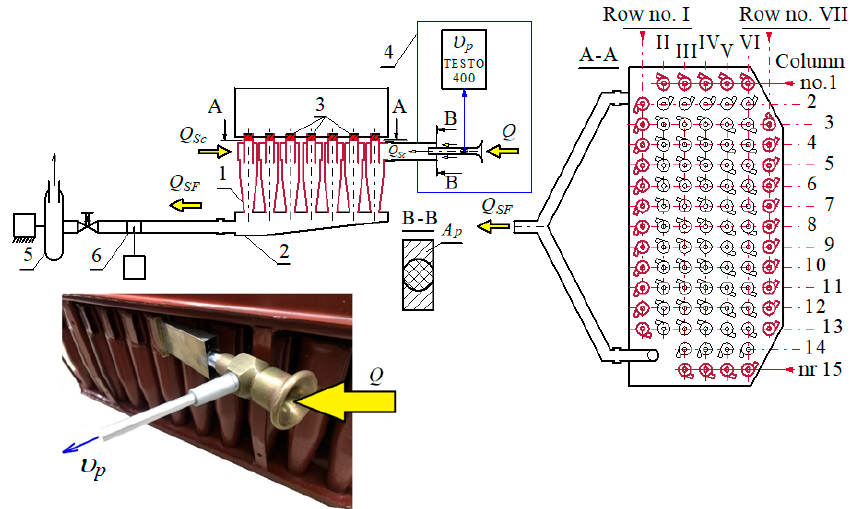
Figure 22. The stand for measurement of the sucked flows from the individual cyclones of the MT multicyclone: 1—multicyclone, 2—dust collector, 3—flow closing plugs, 4—measurement kit, 5—suction fan, 6—sucked flow flowmeter Q SF .